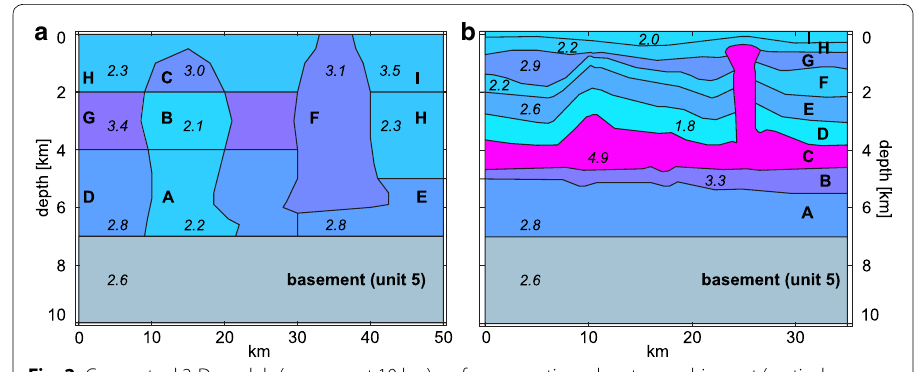
Fig. 2 Conceptual 2‑D models (uppermost 10 km) a of a magmatic and metamorphic crust (vertical exaggeration approx. fourfold) and b of a sedimentary crust (vertical exaggeration approx. threefold). The model rock units (bold capital letters) and the corresponding thermal conductivity under ambient conditions (in italics , given in W m − 1 K − 1 ) are denoted (see Table